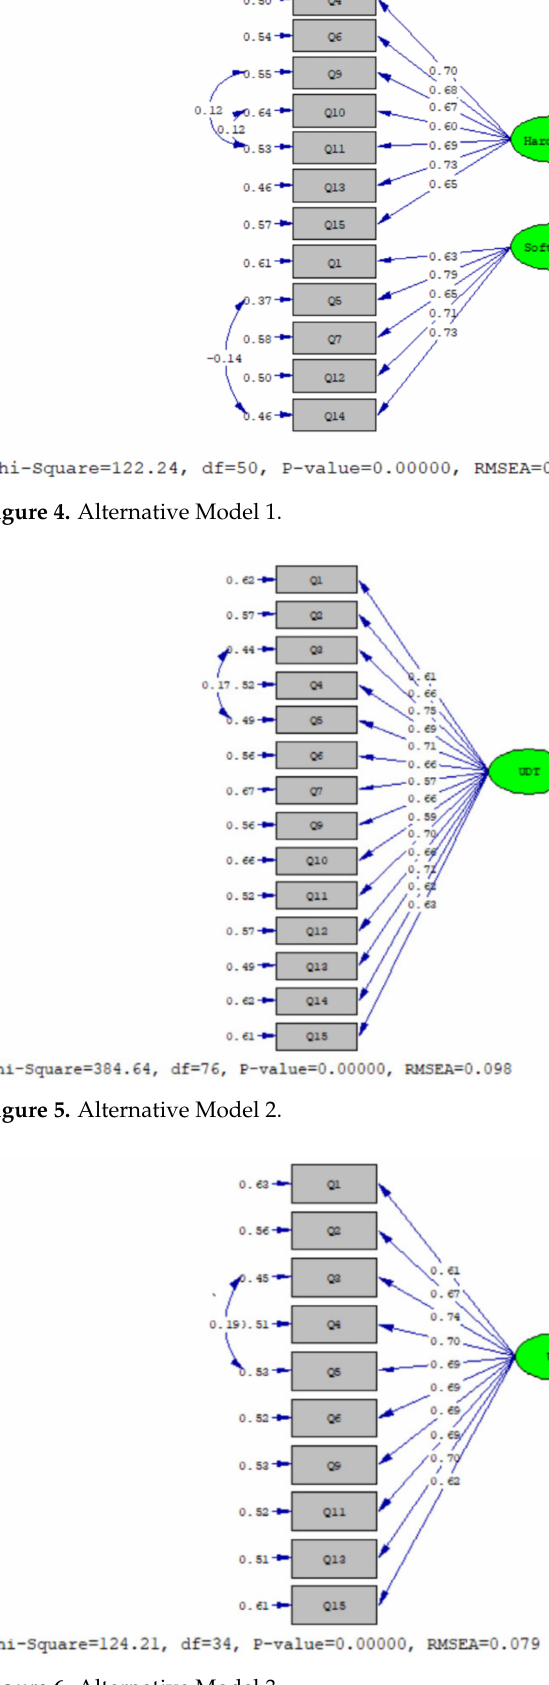
Figure 6. Alternative Model